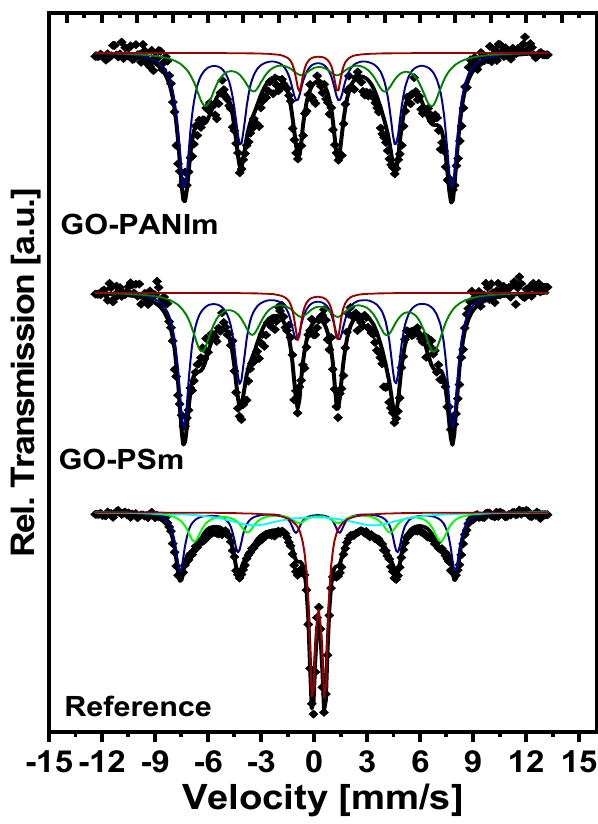
Figure 5. 57 Fe Mössbauer spectra of GO–PANIm, GO–PSm and magnetite as reference.